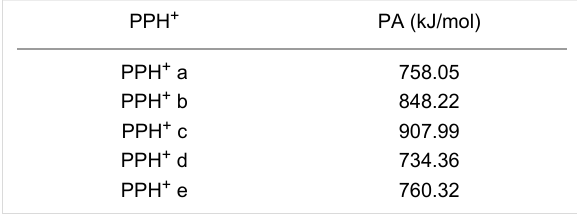
Table 2: The calculated values of the proton affinity of the denoted atoms in the PP molecule (see Figure